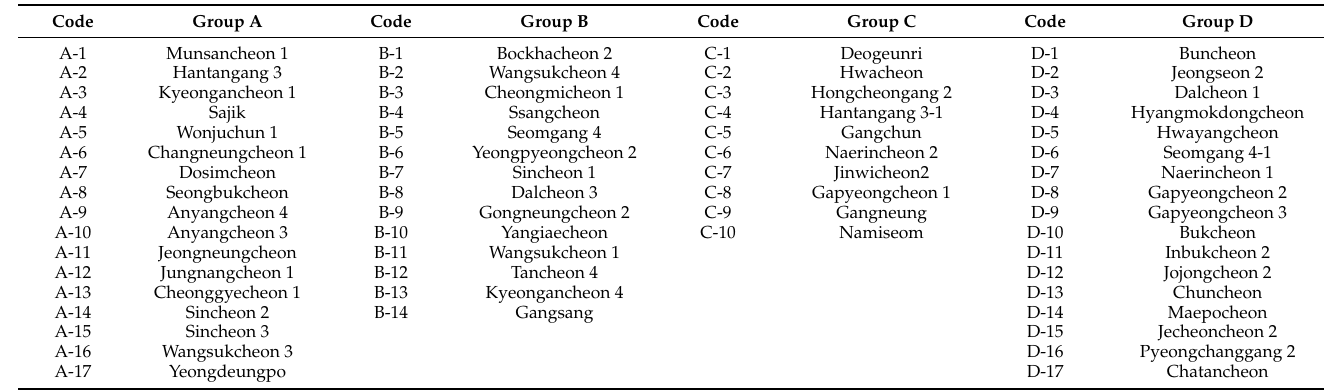
Table 1. The code and name of fifty-eight monitoring sites in the study area along the Han River in South Korea.